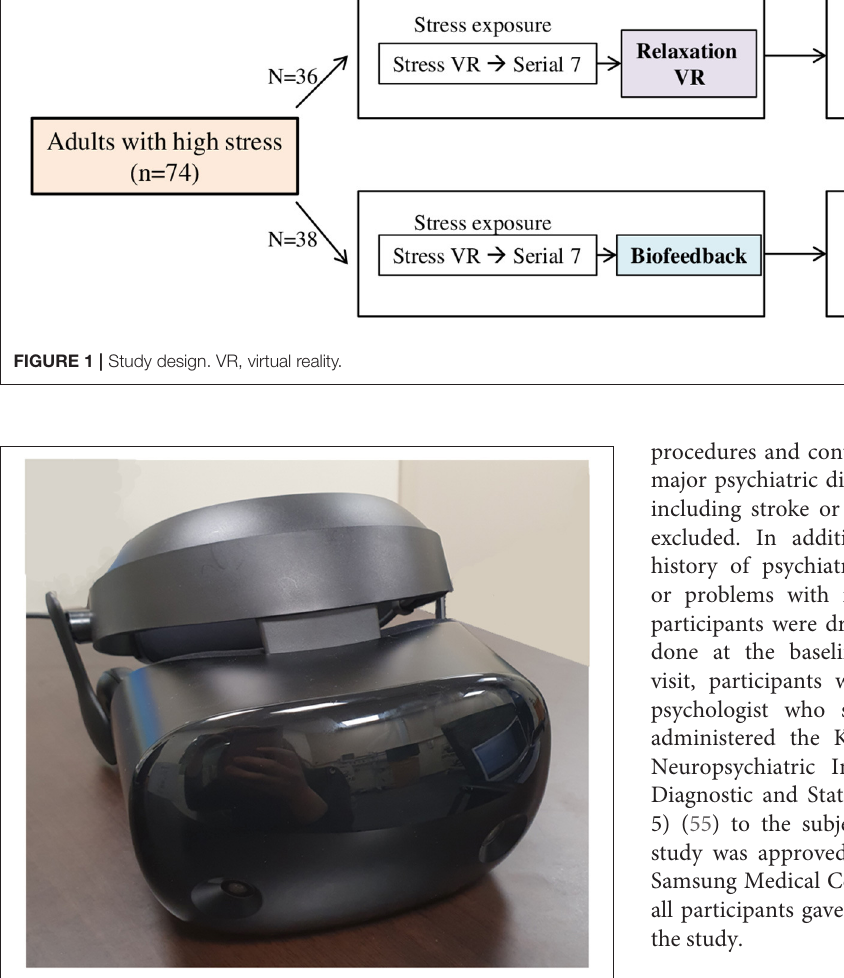
FIGURE 2 | VR device. VR, virtual